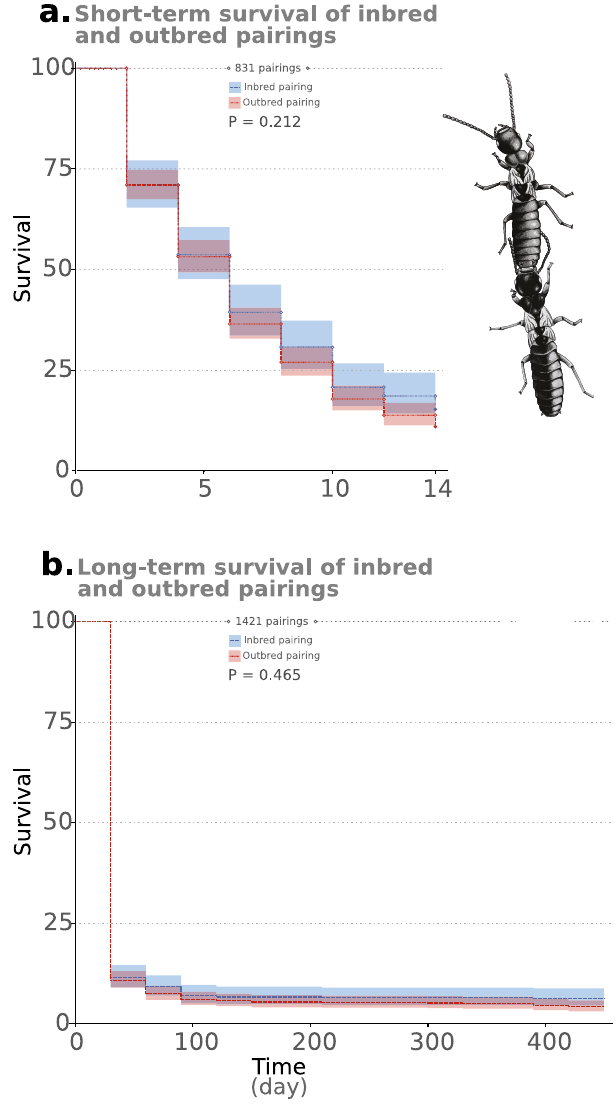
Fig. 1 Short and long-term survival of inbred and outbred pairings. Kaplan – Meier survival distributions of inbred and outbred incipient colonies during the fi rst 14 days after pairing ( a ) and along the overall length of the experiment (450 days; b